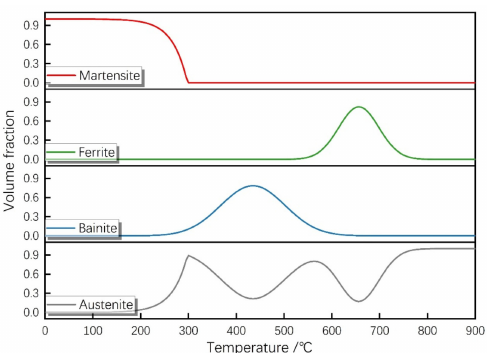
Figure 7. Relationship between volume fraction of each phase and primary